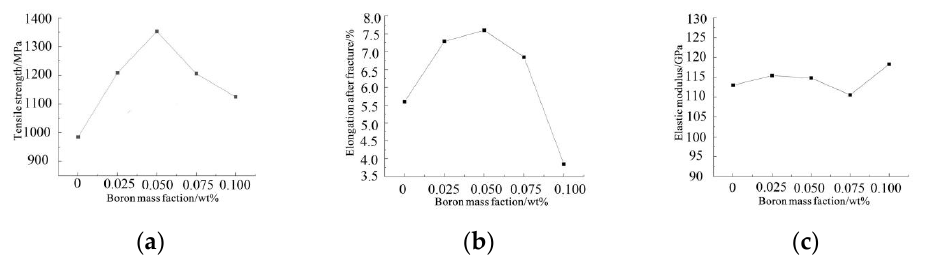
Figure 11. Tensile mechanical properties of SLM-formed Ti6Al4V alloys with different boron contents: ( a ) tensile strength; ( b ) elongation after fracture; ( c ) elastic modulus.